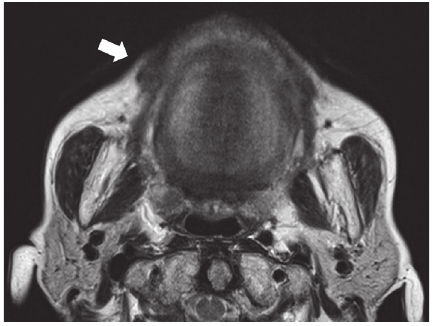
Figure 2: MR image of the lesion (arrow).